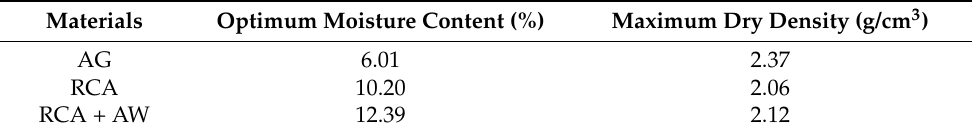
Table 5. California Bearing Ratio (CBR) value and